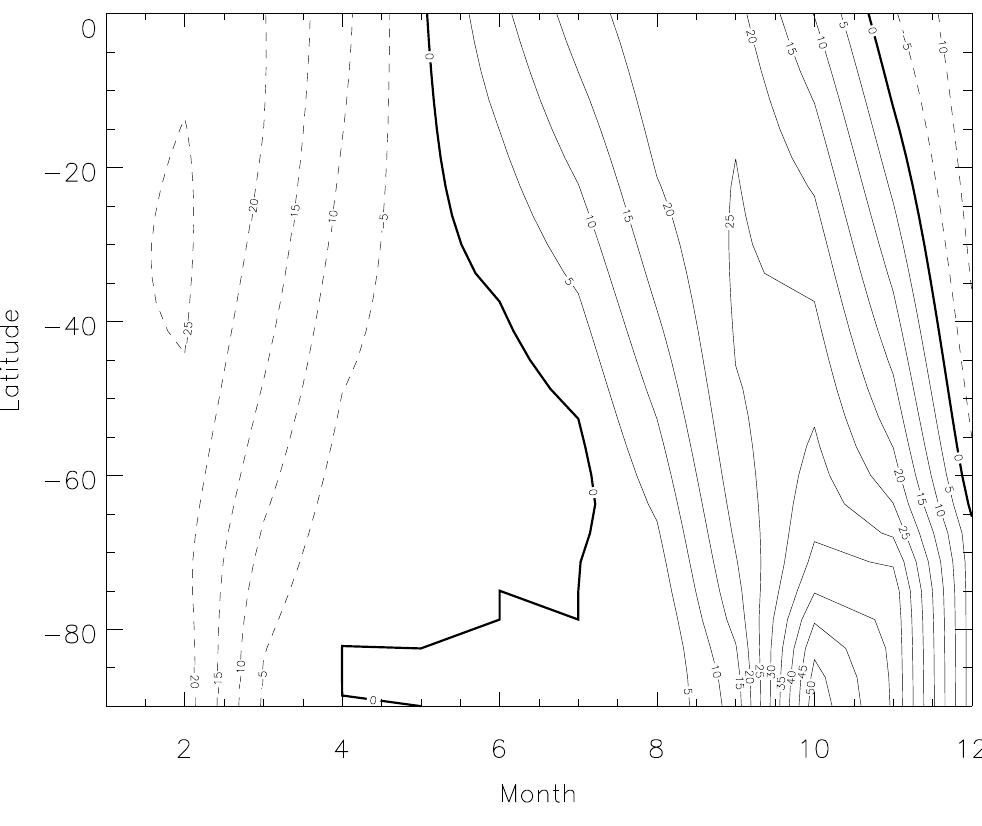
Fig. 2. The calculated difference in zonal, seasonal mean insolation for the Mid-Holocene relative to the pre-industrial control (Wm − 2 ) from Ackerley and Renwick (2010). Positive (negative) values are indicated by the solid (dashed) lines. The zero line is the thick black line.